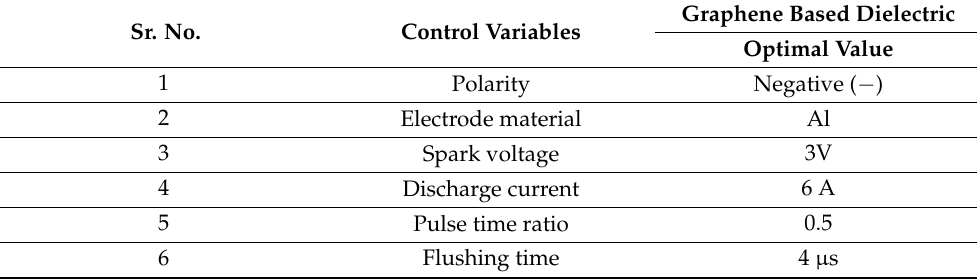
Table 6. Optimal parameter settings of graphene-based dielectric EDM set up yielding the lowest values of R DE and A DE .